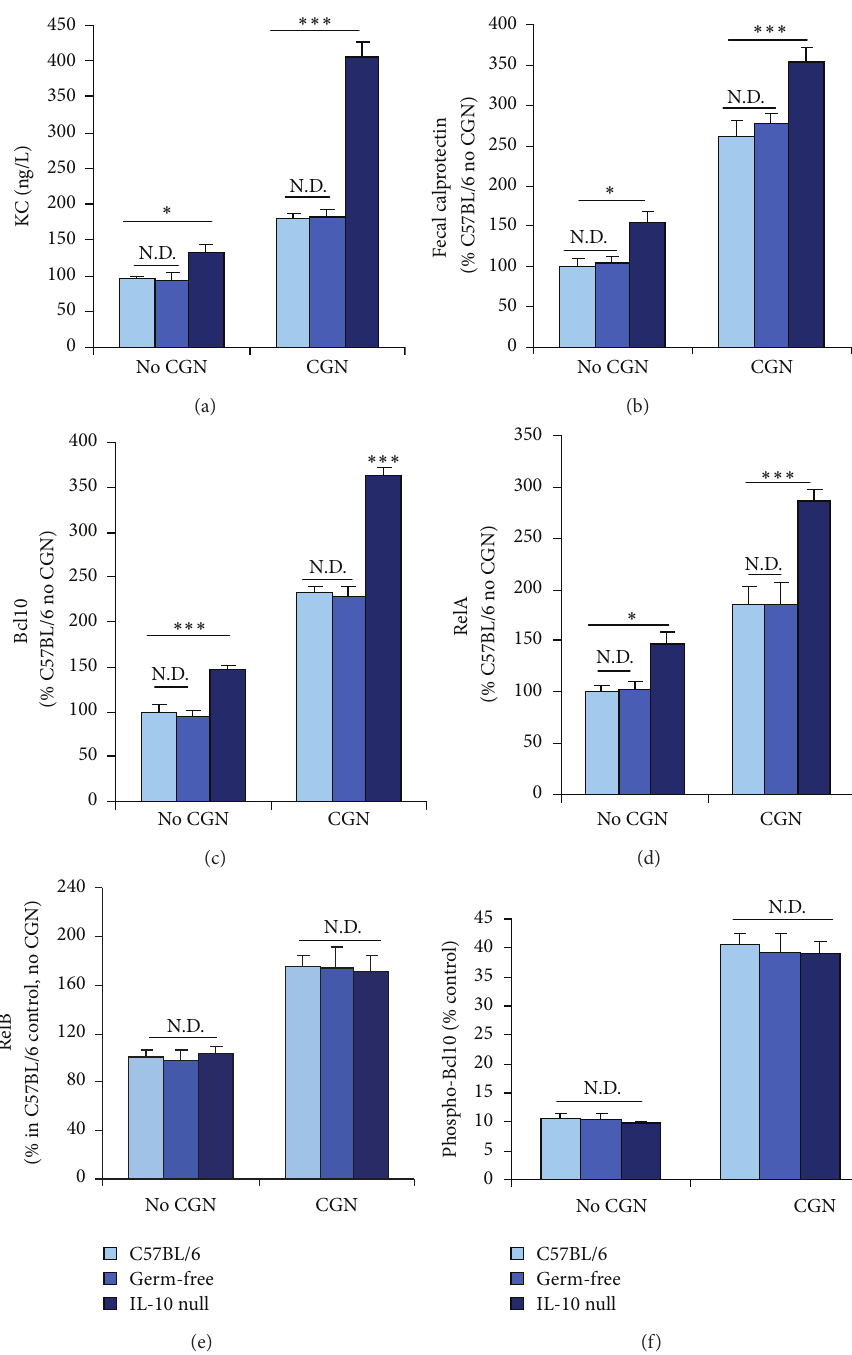
Figure 7: Effects of carrageenan exposure in IL-10-deficient mice compared to C57BL/6 control in germ-free environment and in standard housing. (a) KC was not different in the C57BL/6 germ-free mice versus mice with standard housing at baseline or following carrageenan exposure. In the IL-10-deficient mice, KC was greater at baseline ( 𝑃 < 0.05 ) and following carrageenan ( 𝑃 < 0.001 ) than in the control